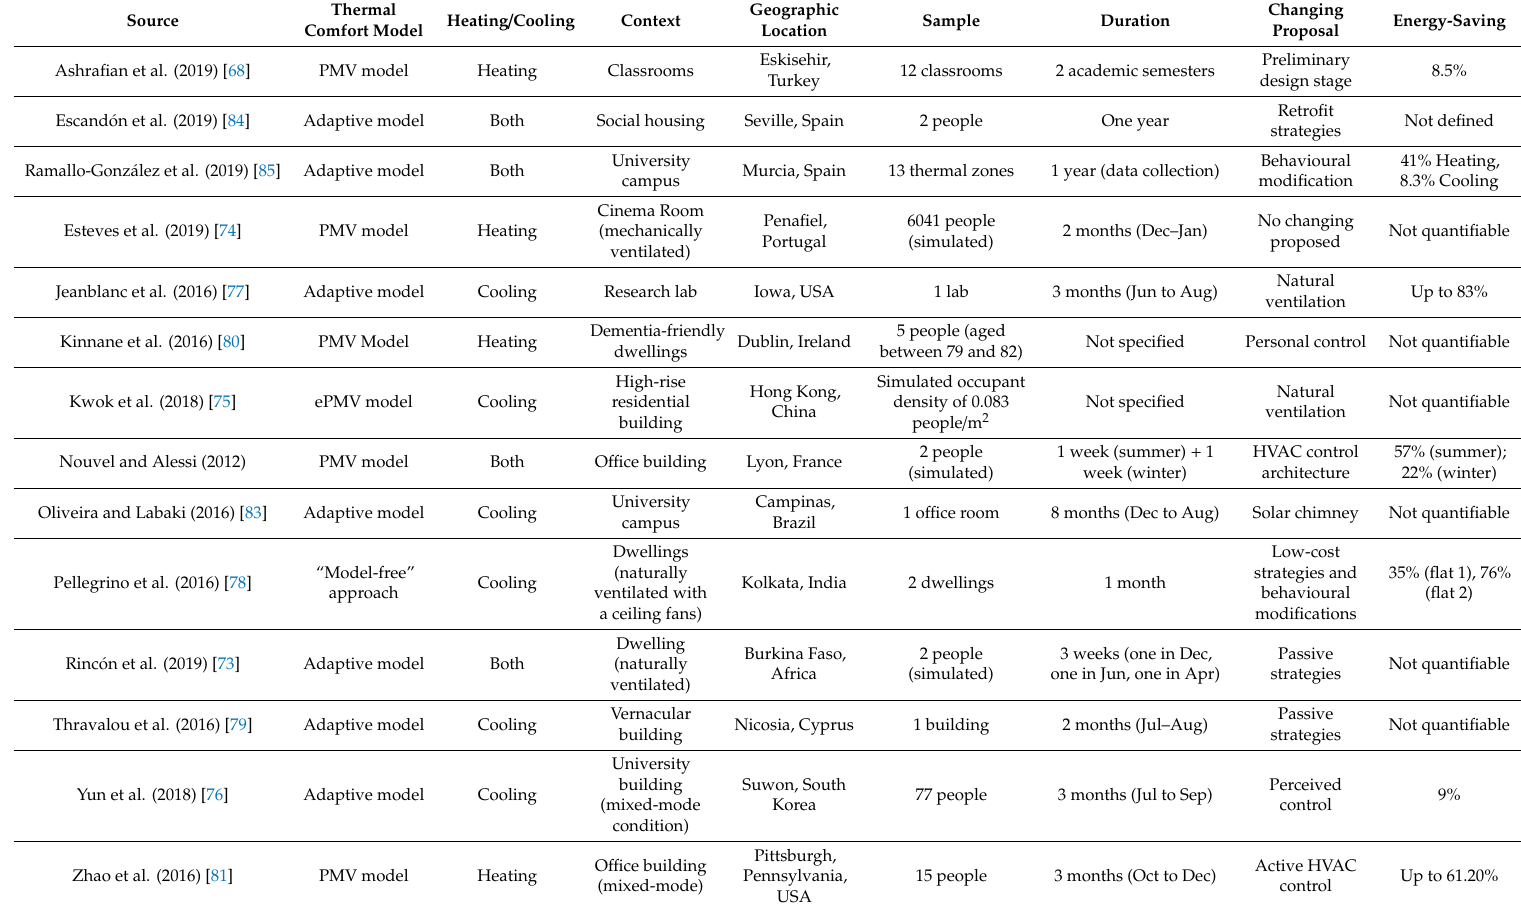
Table 3. Main contributions using the EnergyPlus (EP)